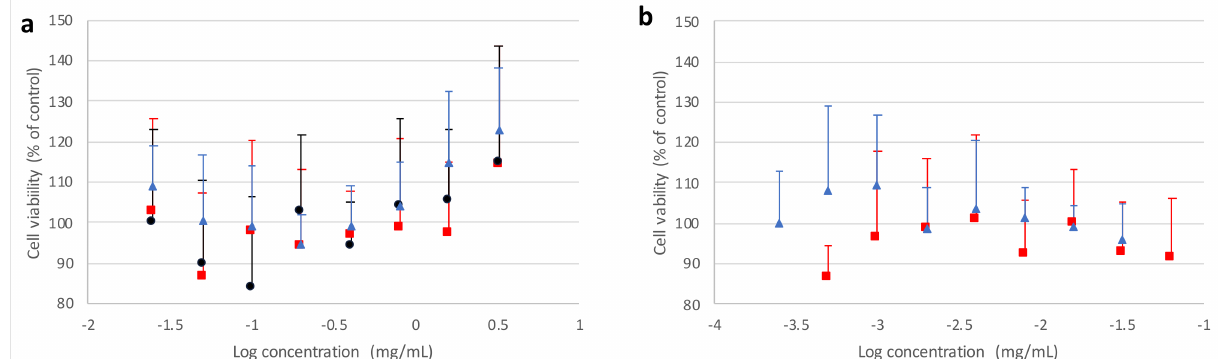
Figure 10. Viability of A549 cells after 24 h of contact with ( a ) mannitol polymorphs α (red square), β (black circle), δ (blue triangle), or ( b ) corresponding nominal amounts of doping agents PVA (red square) or PVP (blue triangle). The bars represent standard deviation ( n =